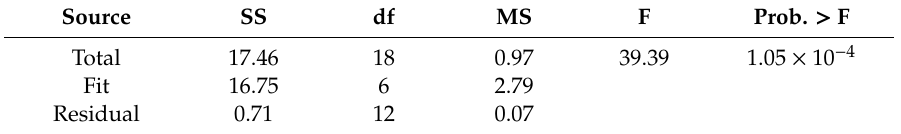
Table 4. Statistical significance of the consensus GA-PLS model for the IAM.PC.DD2.